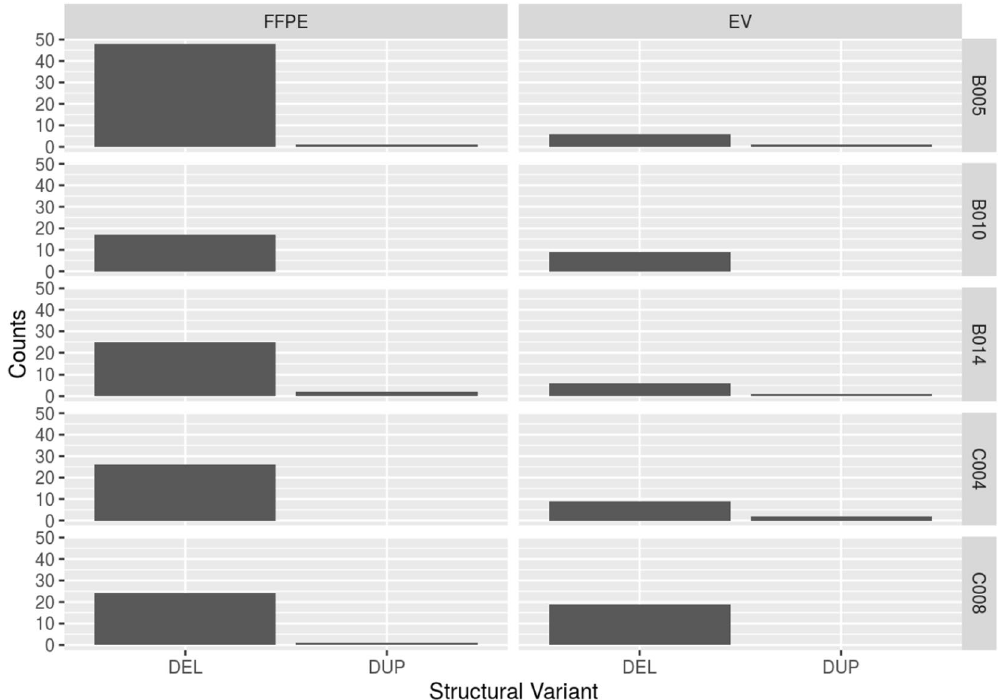
Figure 3. Comparison of CNA counts (deletion (DEL), or duplication (DUP)) of EV and FFPE samples, with patient ID labelled on the right of the figure. CNA counts are plotted on Y-axis. Segmentation analysis was performed using QDNASeq and the resultant output files were summarised using R, version 1.6.2 20